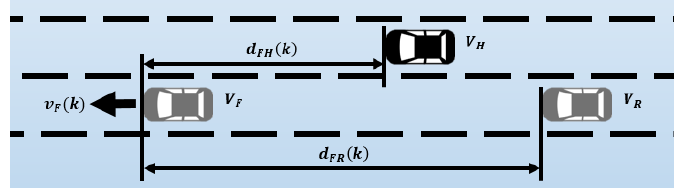
Figure 3. Diagram of the parameters used in calculating each gap’s